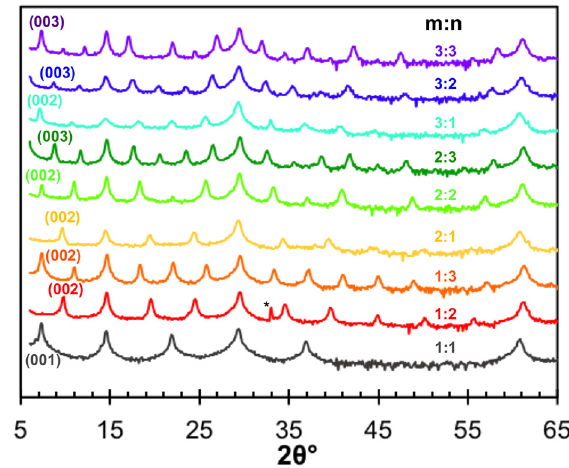
Figure 11. Diffraction patterns for the unique combinations of m:n (Cu K α ). All maxima can be indexed to 00l reflections (* = substrate